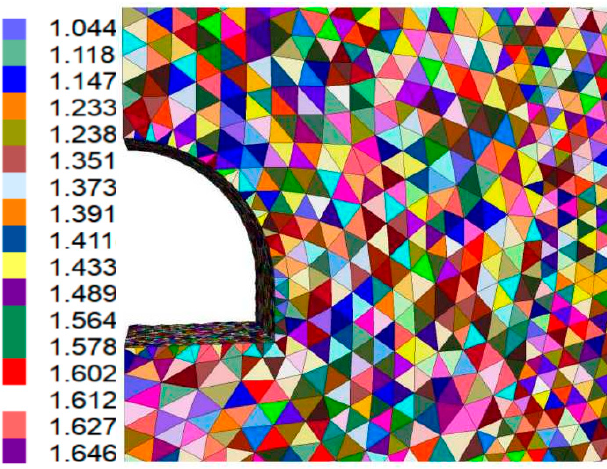
Figure 6. Cohesion values (in megapascals) adopted in the individual elements of finite differences, after adopting the variability coefficient equal to 20%.